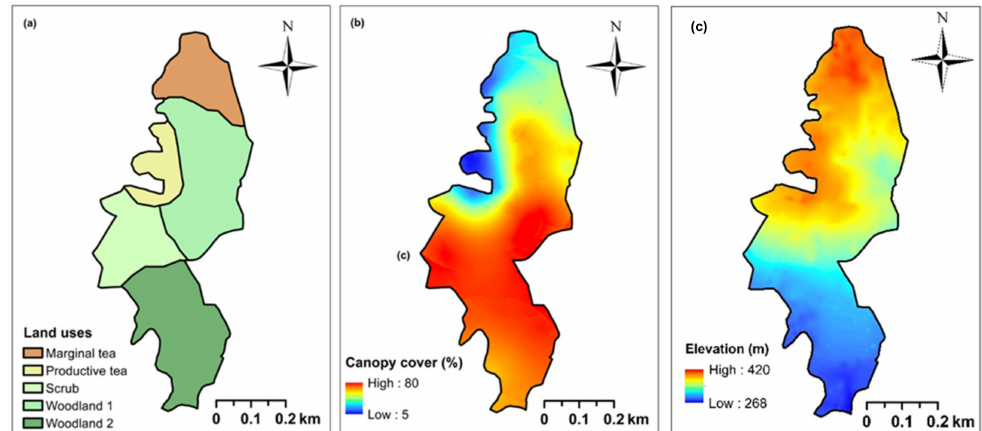
Figure 2. Maps indicating ( a ) five land use categories: productive tea lands (PT), marginal tea lands (MT), scrub (SC), and two woodlands (WD1 and WD2); ( b ) the variation in forest canopy cover; and ( c ) digital elevation model (See Appendix A, Figure A1 for elevational profile) in a tea-forest interface in the Endane Biodiversity Corridor, Dilmah Conservation and Kahawaththa Plantations PLC., located adjacent to the Sinharaja Rainforest Complex in Rathnapura District of Sri Lanka. The southern end of this site connects to the Sinharaja Rainforest Complex, while the northern end connects with the Iharakanda Proposed Forest Reserve through a few agroforests, as seen in Figure